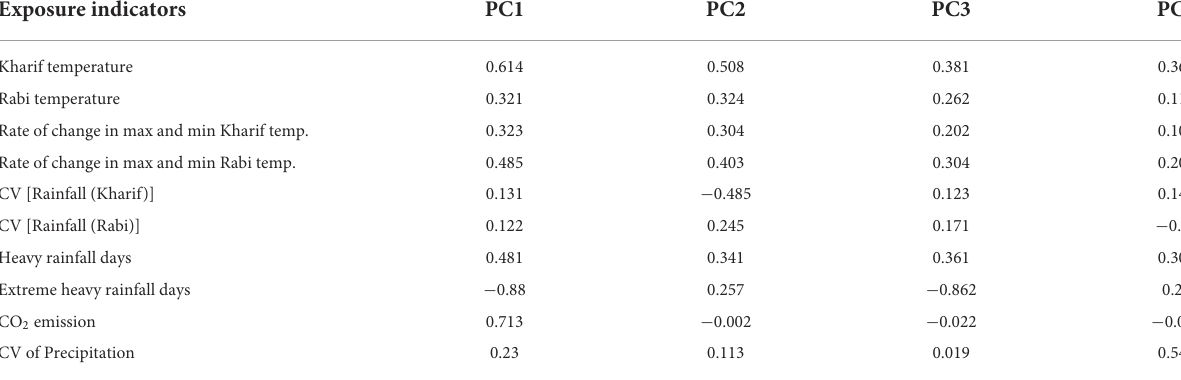
TABLE 5 Non-rotated factor loadings from principal components of exposure